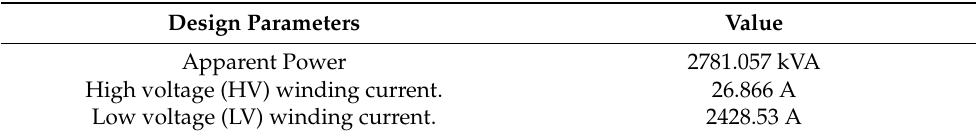
Table 2. Apparent power and winding currents in the transformer design calculated under the harmonic profile.